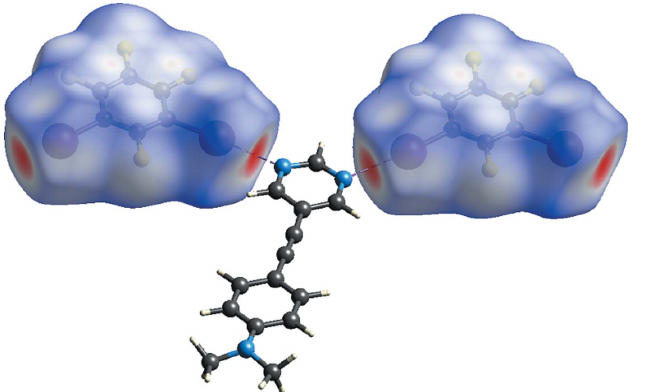
Figure 3 Hirshfeld surface highlighting the halogen-bonding interactions to pyrimidine APEP.